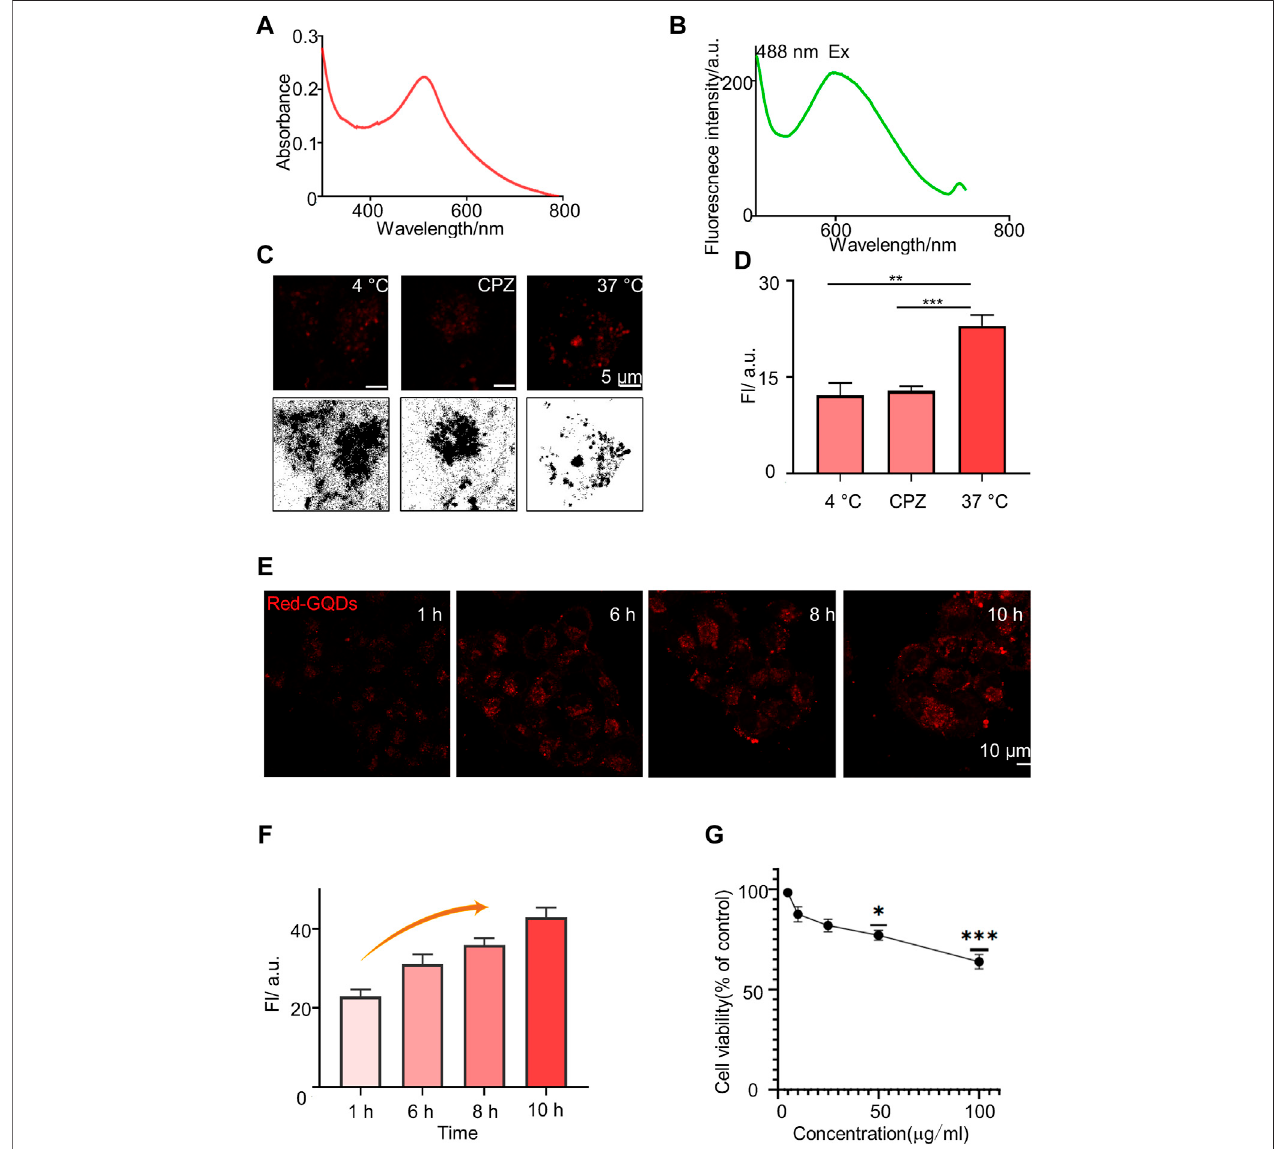
FIGURE1| Characterization ofRed-GQDs. (A) Absorptionspectrum ofRed-GQDs (10 μ g/ml). (B) FluorescencespectrachangesofRed-GQDs (10 μ g/ml). λ ex= 488 nmand λ em=599.6 nm. (C) FluorescenceandgrayscaleimagesofHeLacellspretreatedwithlowertemperature (4 ° C),chlorpromazine(CPZ,20 μ M)andthenco- stained with Red-GQDs (10 μ g/ml, 1 h). (D) Fluorescence intensity of Red-GQDs with 4 ° C, CPZ and 37 ° C. Data are presented as mean ± SEM. p < 0.05 is considered signi fi cant( n =3,** p < 0.01,*** p < 0.001, and **** p < 0.0001). All compared with37 ° C. (E) PermeabilityoftheRed-GQDs (10 μ g/ml)at times of1,6, 8,and 10 h in HeLacells. (F) FluorescenceintensitychangesofHeLacellstreatedwithRed-GQDs(10 μ g/ml)for1,6,8,and10 h. (G) EffectsofRed-GQDsoncellviabilityinHeLacells treated with concentrations ranging from 5 to 100 μ g/ml for 24 h measured by CCK8 assay.